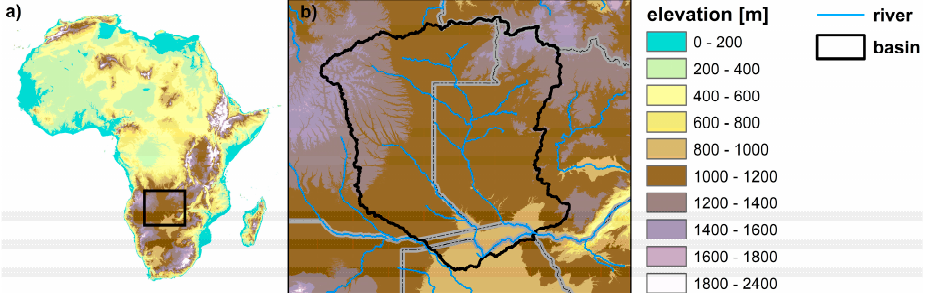
Figure 1. Location of the Upper Zambezi River Basin (UZRB) within the African continent with topographic data and stream networks at 15 arc sec spatial resolution from USGS HydroSHEDS (https://hydrosheds.cr.usgs.gov/data.php). ( a ) Digital elevation map of the African continent with box highlighting area in panel ( b ). ( b ) Digital elevation map of UZRB river basin with stream networks displayed. Gray lines indicate country borders.